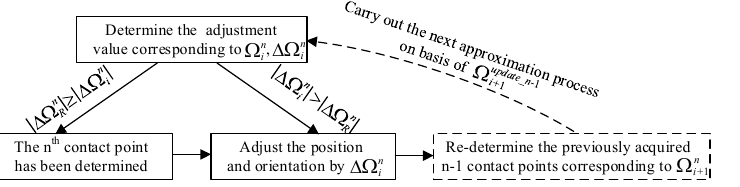
Figure 5. Principle of searching for a contact point via progressively approaching position and orientation.